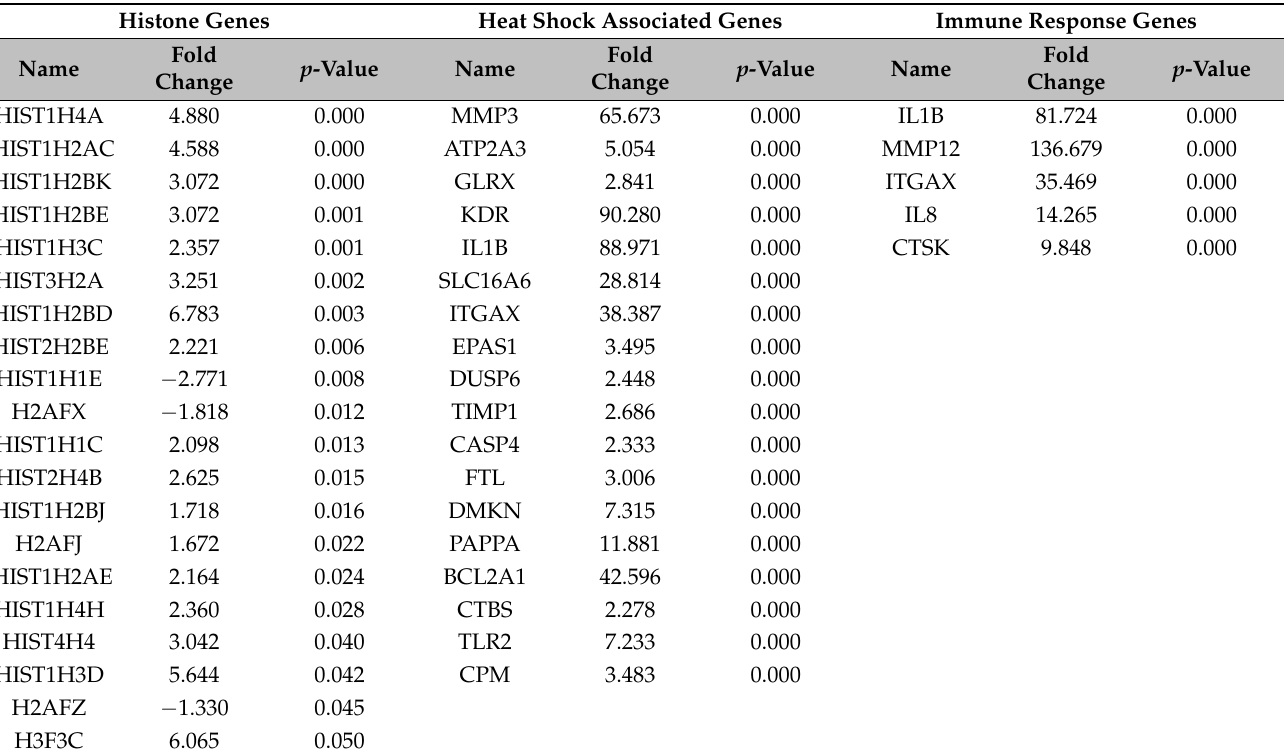
Table 3. Results of RNA-Seq analysis for three different gene